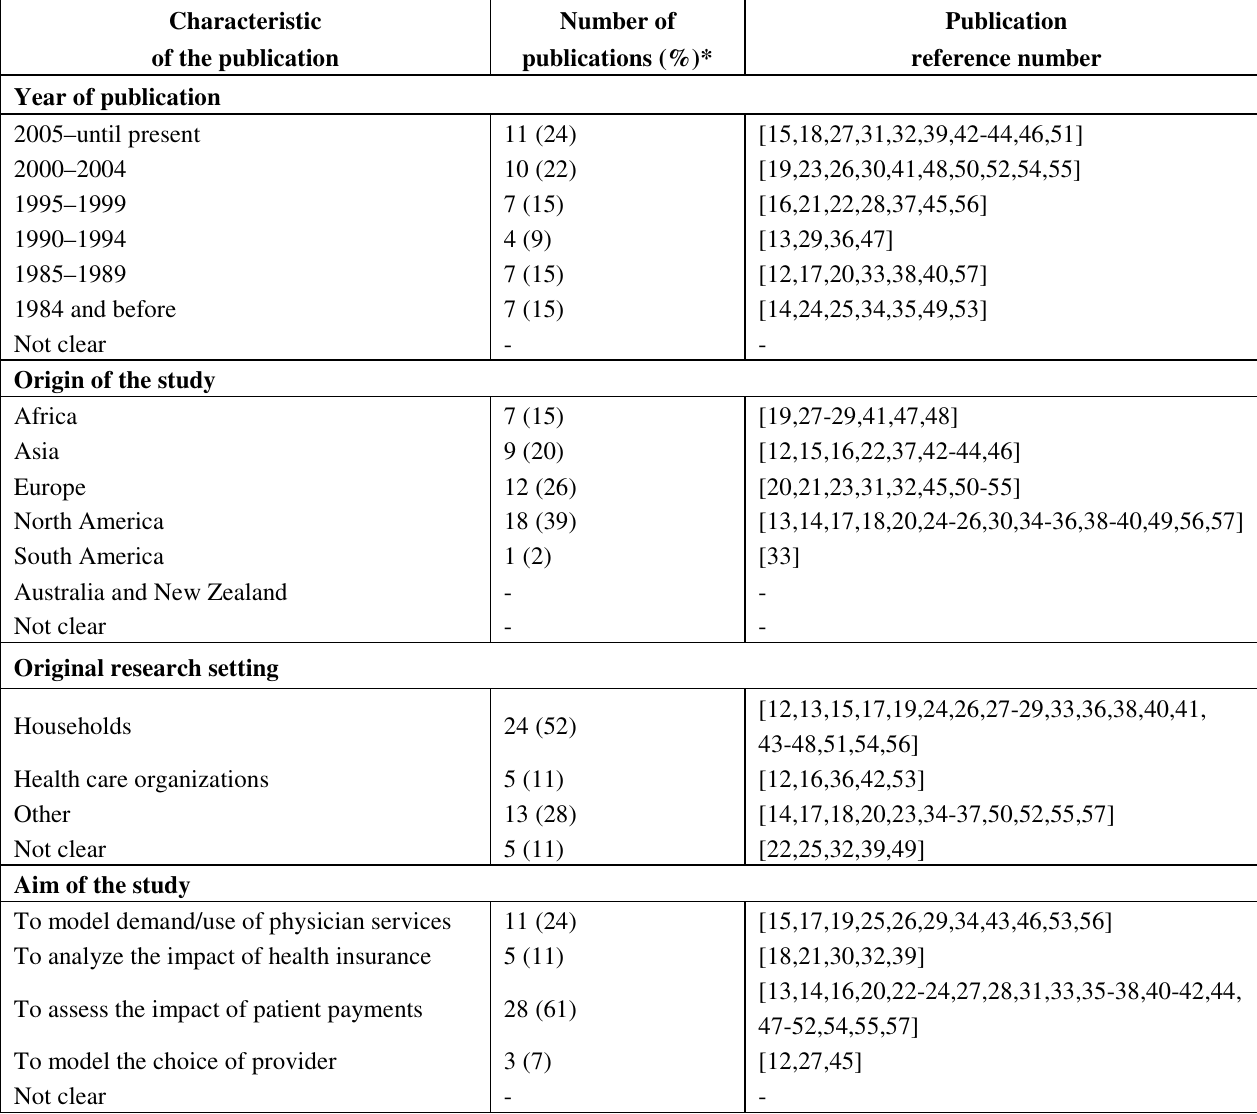
Table 1. Overall characteristics of the 46 publications included in the